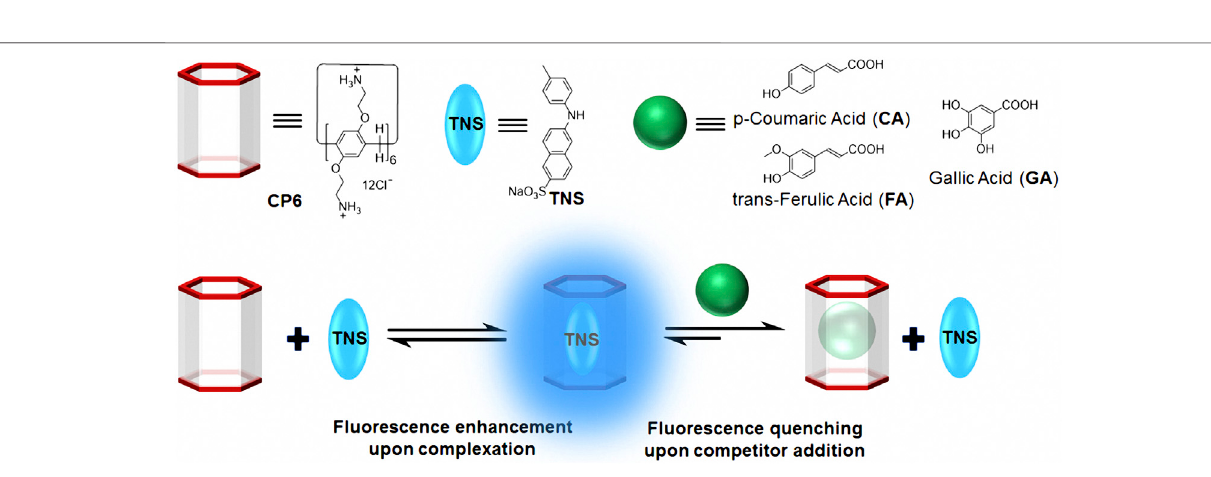
( Supplementary Figure S1 ) establish a correlation between the naphthyl protons (H a-f ) in the entrapped TNS and the aromatic proton H 1 in CP6 , revealing the interpenetrated